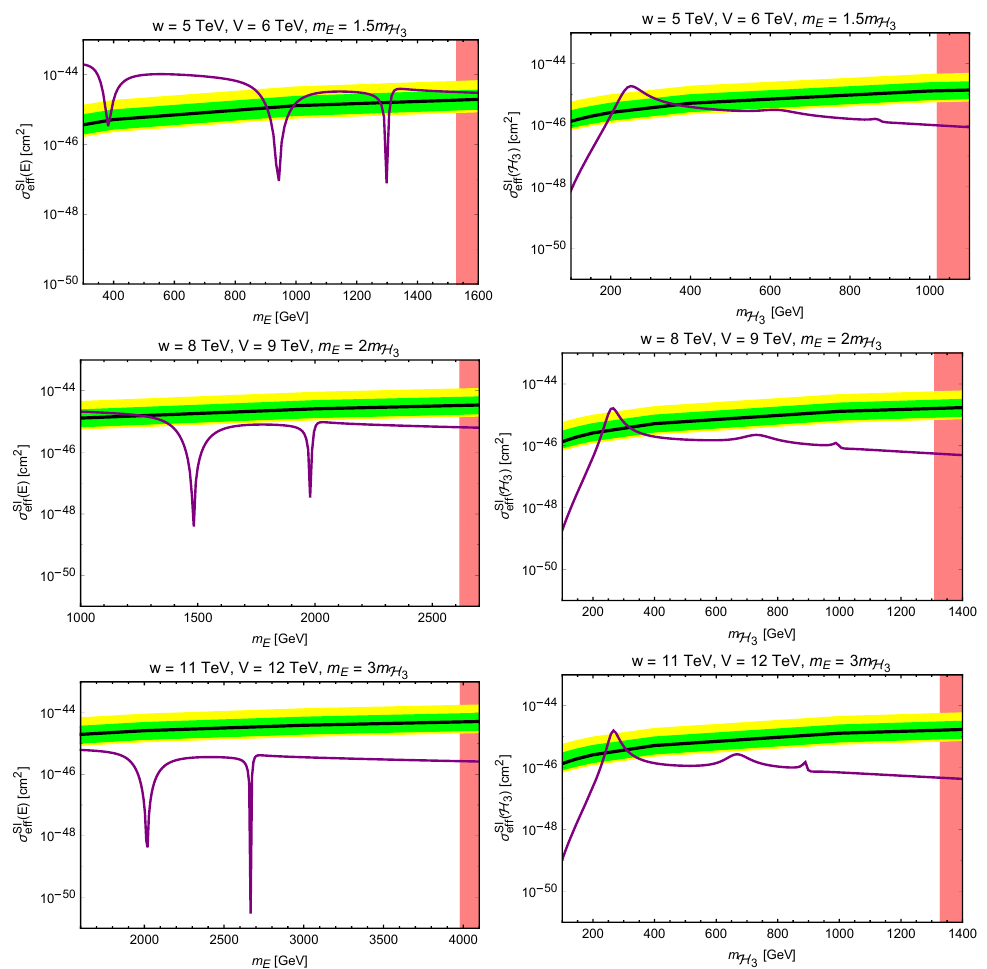
Figure 16 . Direct detection cross-sections of fermion and scalar dark matter components plotted as the function of the corresponding dark matter mass according to the choices of the dark matter mass relations and w; V